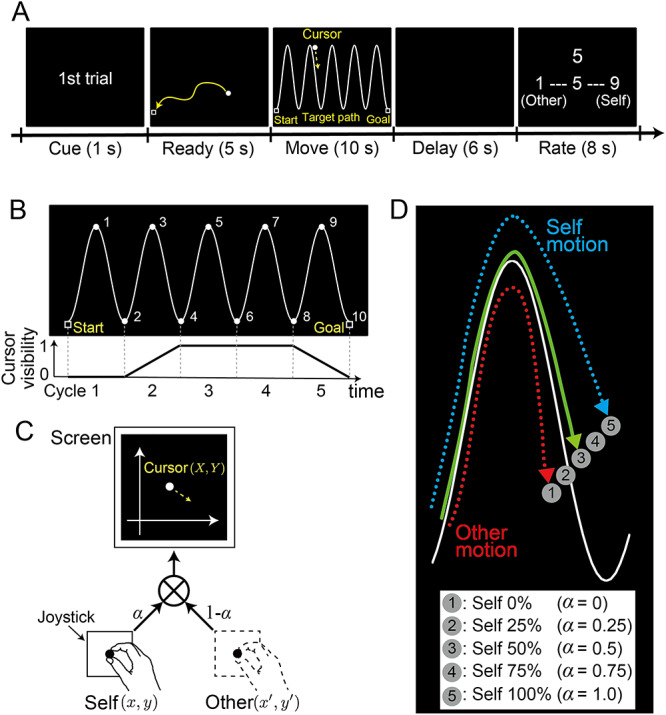
(A) Trial timeline. After moving a cursor to the start position (shown as a square) during the 5-s ready period, participants traced a sinusoidal target-path with a cursor controlled by a joystick during the 10-s move period. Following a 6-s delay period, participants assigned a score (on a 9-point Likert scale) to their self-other attribution by pushing buttons. (B) Target path (top). Numbers were sequentially presented every second to help participants maintain the required pace of tracing. Cursor visibility (bottom). The cursor was invisible on the screen during the first 2.0 s (first cycle). Visibility linearly increased from zero to one over the next 2.0 s (second cycle). Here, zero corresponds to black (RGB: 0, 0, 0), which is the same brightness as the background, while one corresponds to white (RGB: 255, 255, 255). The cursor continued to be clearly visible during the next 4.0 s (third and fourth cycles) and then linearly became darker from 8.0 to 10 s (fifth cycle). (C) Morphing method. Cursor position on the screen (X, Y) was the weighted summation of the joystick position controlled by the current participant (self) (x, y) and a pre-recorded joystick position (other) (x’, y’). Weights were modified by a morphing ratio (\documentclass[12pt]{minimal}
\usepackage{amsmath}
\usepackage{wasysym} 
\usepackage{amsfonts} 
\usepackage{amssymb} 
\usepackage{amsbsy}
\usepackage{upgreek}
\usepackage{mathrsfs}
\setlength{\oddsidemargin}{-69pt}
\begin{document}
}{}$\alpha$\end{document}). (D) Cursor trajectories. Circles labeled with numbers (1–5) illustrate how the cursor position was changed according to the five morphing ratios (\documentclass[12pt]{minimal}
\usepackage{amsmath}
\usepackage{wasysym} 
\usepackage{amsfonts} 
\usepackage{amssymb} 
\usepackage{amsbsy}
\usepackage{upgreek}
\usepackage{mathrsfs}
\setlength{\oddsidemargin}{-69pt}
\begin{document}
}{}$0\le \alpha \le 1$\end{document}): self 0% (number 1) to self 100% (number 5) at every 25% step. In the self-other mixed conditions (number 2, 3, or 4), the cursor was displayed between the position of the participant’s own joystick and the position of the other person’s joystick.